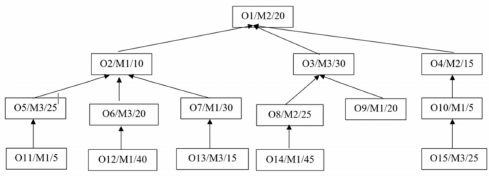
Figure 20. An example of a processing operation tree